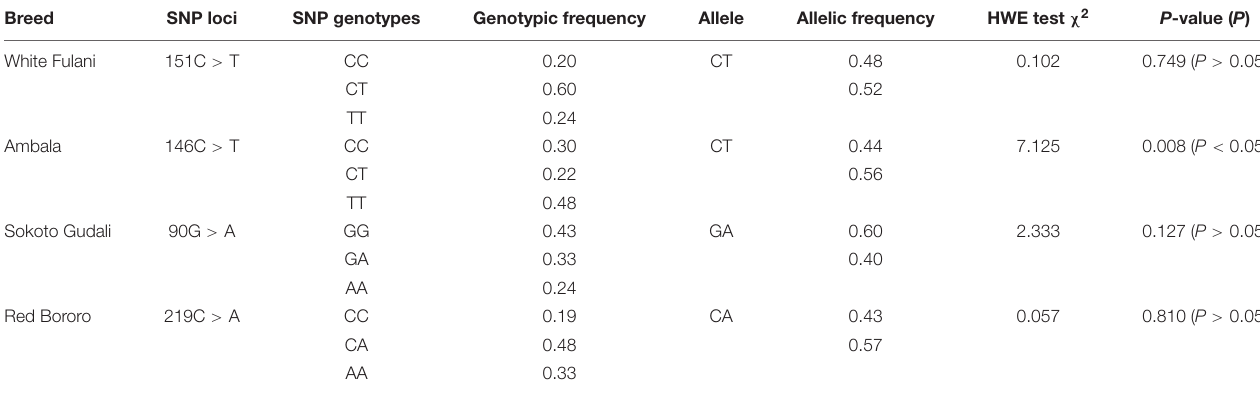
TABLE 6 | Genotypic and allelic frequencies of SNPs identified in the present study. Breed SNP loci SNP genotypes Genotypic frequency Allele Allelic frequency HWE test χ 2